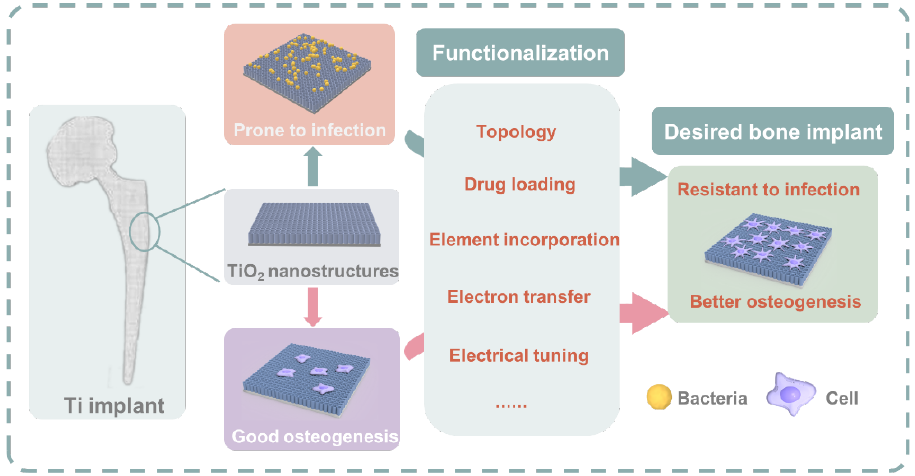
Figure 1. The schematic illustration of functionalization approaches towards the desired orthopedic